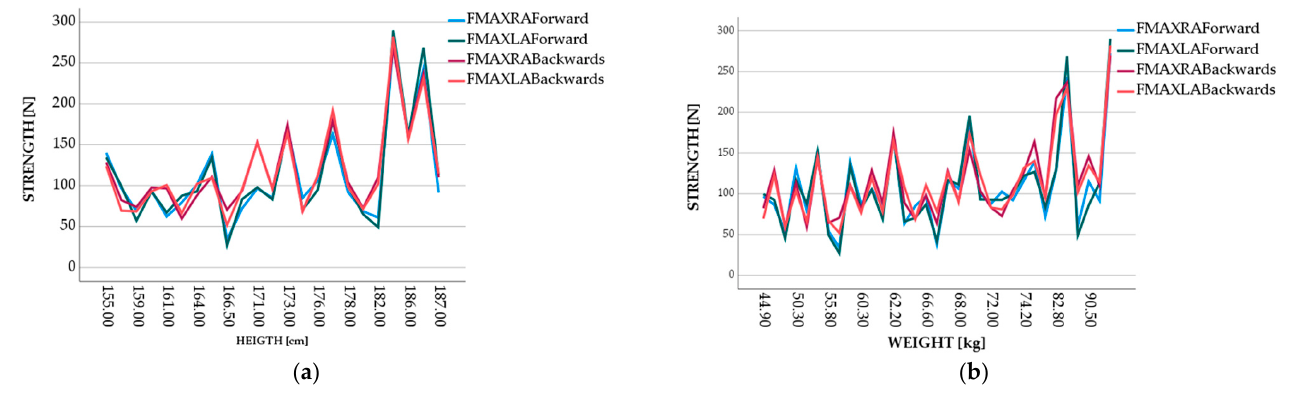
Figure 4. Visualization of graph: ( a ) height–strength; ( b ) weight–strength.